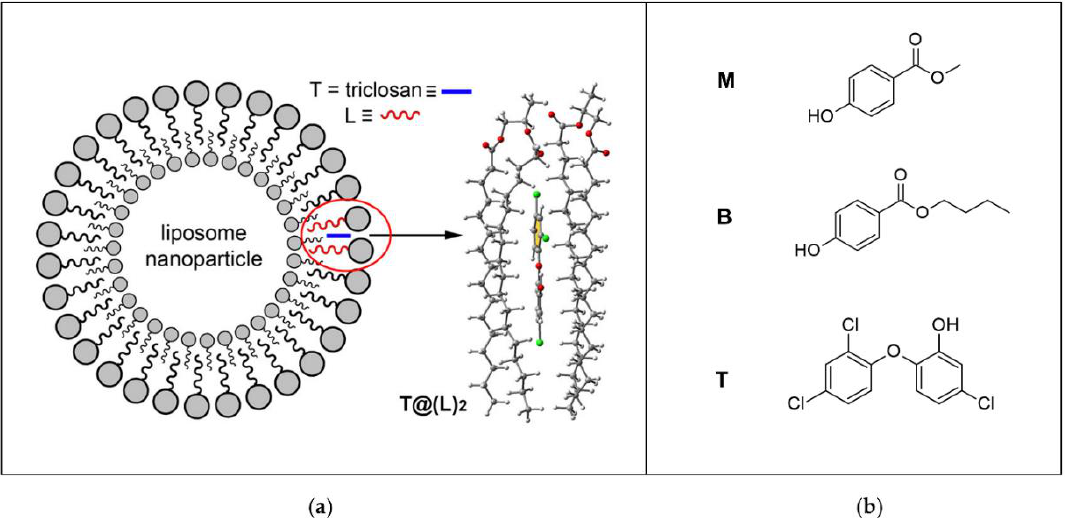
Figure 10. ( a ) Schematic representation of the liposomal nanoparticle and in-silico DFT model of the complex of a dimer of the hydrophobic acyl chain region of the phospholipid with triclosan (T@(L) 2 ); ( b ) target contaminants explored: methylparaben (M), butylparaben (B) and triclosan (T). Figure adapted with permission from reference [102]. Copyright 2016 American Chemical Society.